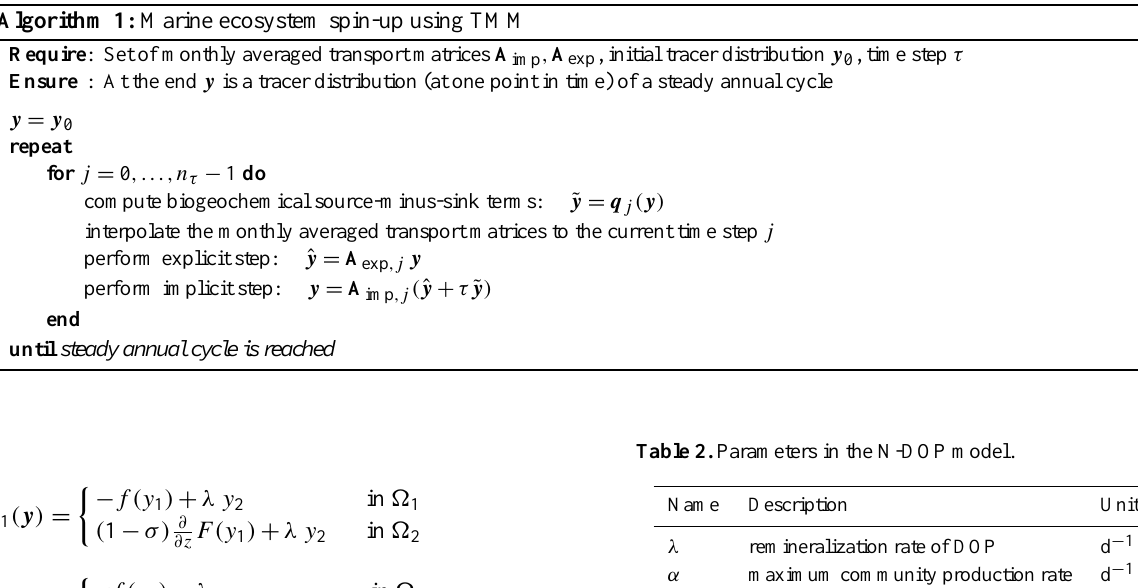
Algorithm 1: Marine ecosystem spin-up using TMM